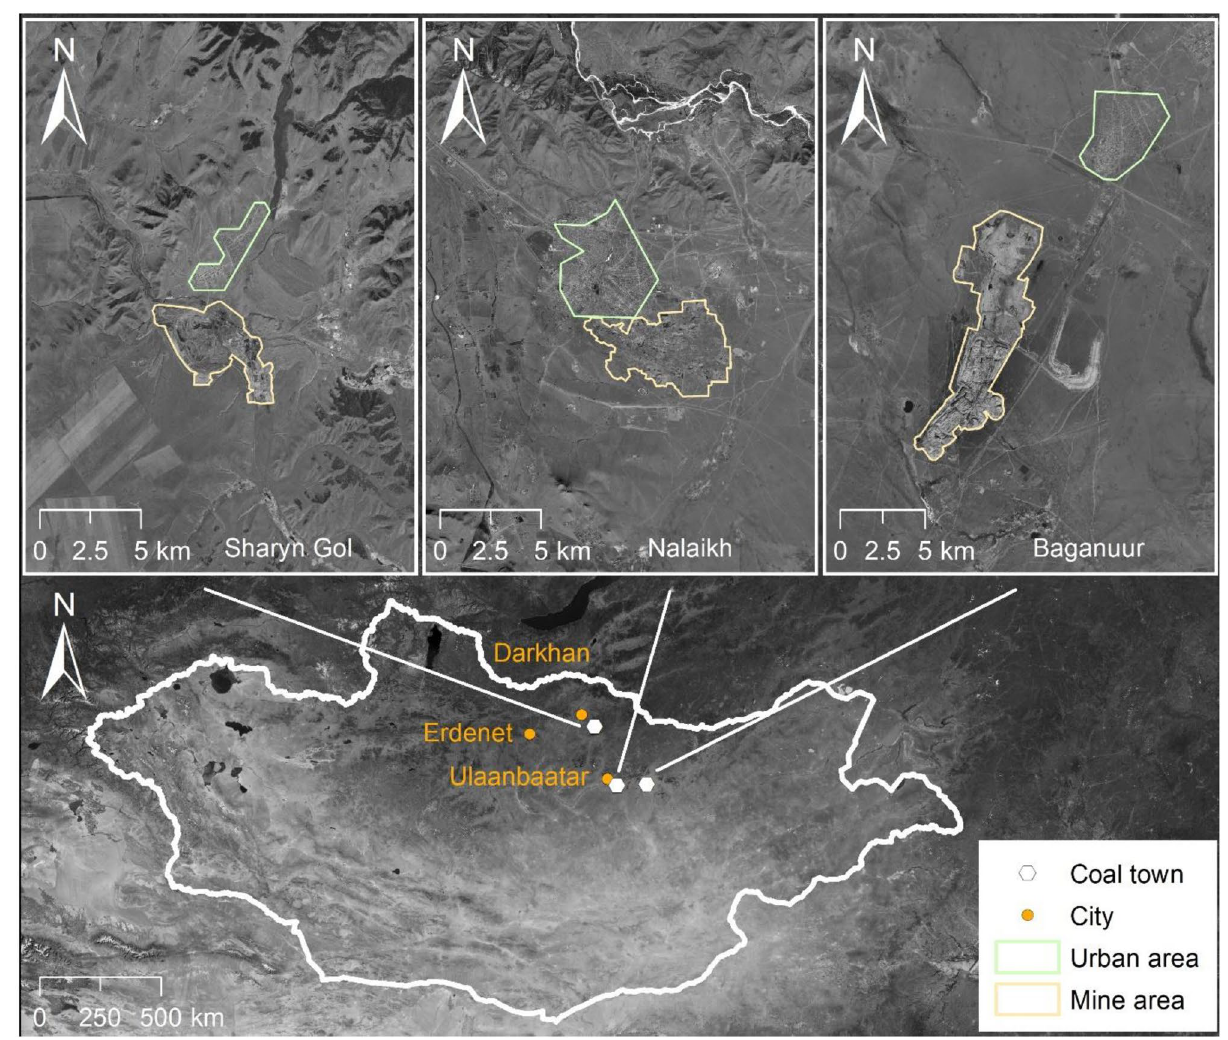
Figure 1. Location of the studied towns and three largest cities in the context of Mongolia. ArcGIS Desktop 10.8.1 software (Esri, CA, USA; https:// www. esri. com/ en- us/ arcgis/ produ cts/ arcgis- deskt op) was used to create the map. The layers of satellite imagery were generated using Esri World Imagery